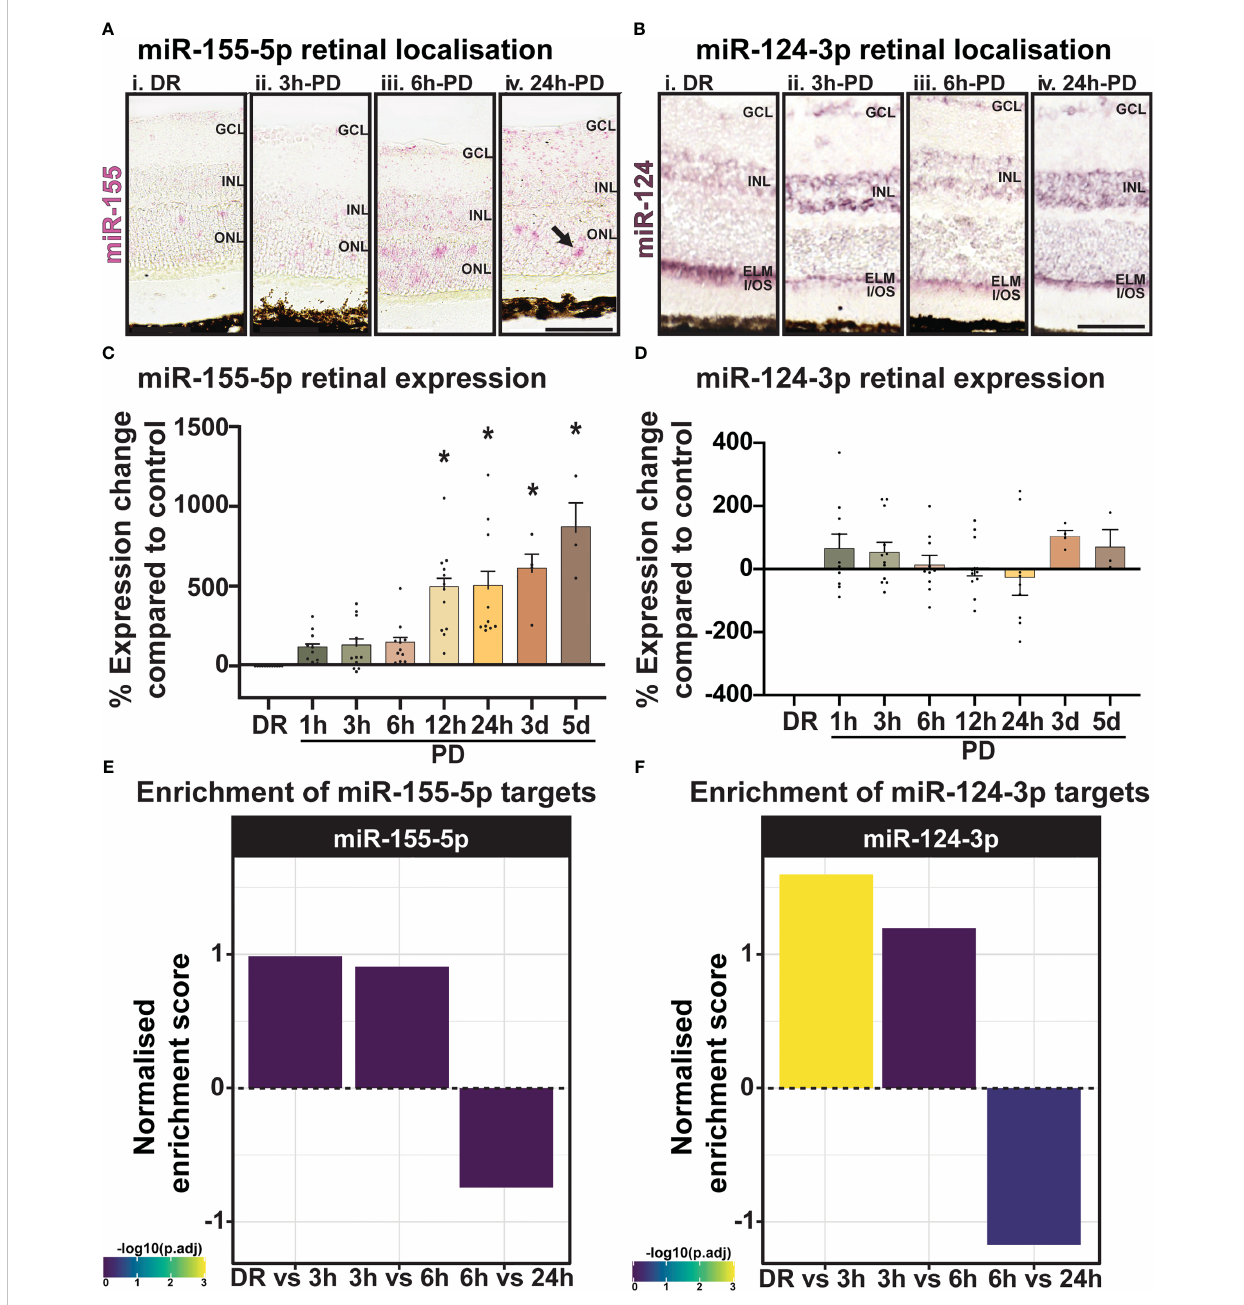
FIGURE 10 miR-155 expression progressively increases in the ONL across PD. (A) Using miRNAscope, the expression and localization of miR-155-5p (pink) was found to increase progressively during PD, with strong punctate labelling shown in the ONL at (A iii ) 6h-PD and (A iv ) 24h-PD compared to controls. Inner retinal (INL-GCL) labelling was also strongly observed at ( Aiv ) 24h-PD. (B) In situ hybridization for miR-124-3p (purple) shows (B i ) strong labelling in the outer limiting membrane (OLM) in DR controls, with weak labelling in the INL and ONL. Labelling in the OLM decreased in appearance by (B ii ) 3h-PD, with increased expression of miR-124-3p found in the INL. (C, D) qRT-PCR showed (C) progressively increased miR-155 expression levels in the retina in response to PD, with signi fi cant upregulation at each time point from 12h-PD to 5d-PD, (D) however no change in expression of miR-124-3p was seen at any time-point across degeneration. (E, F) Normalized enrichment of miR-155-5p and miR-124-3p targets across photo-oxidative damage show increased target enrichment between DR and 6h-PD, and decreased enrichment from 6h-PD to 24h-PD *Signi fi cance using a one-way ANOVA, p < 0.05 and error bars indicate SEM. Scale bar = 50 m M. n =